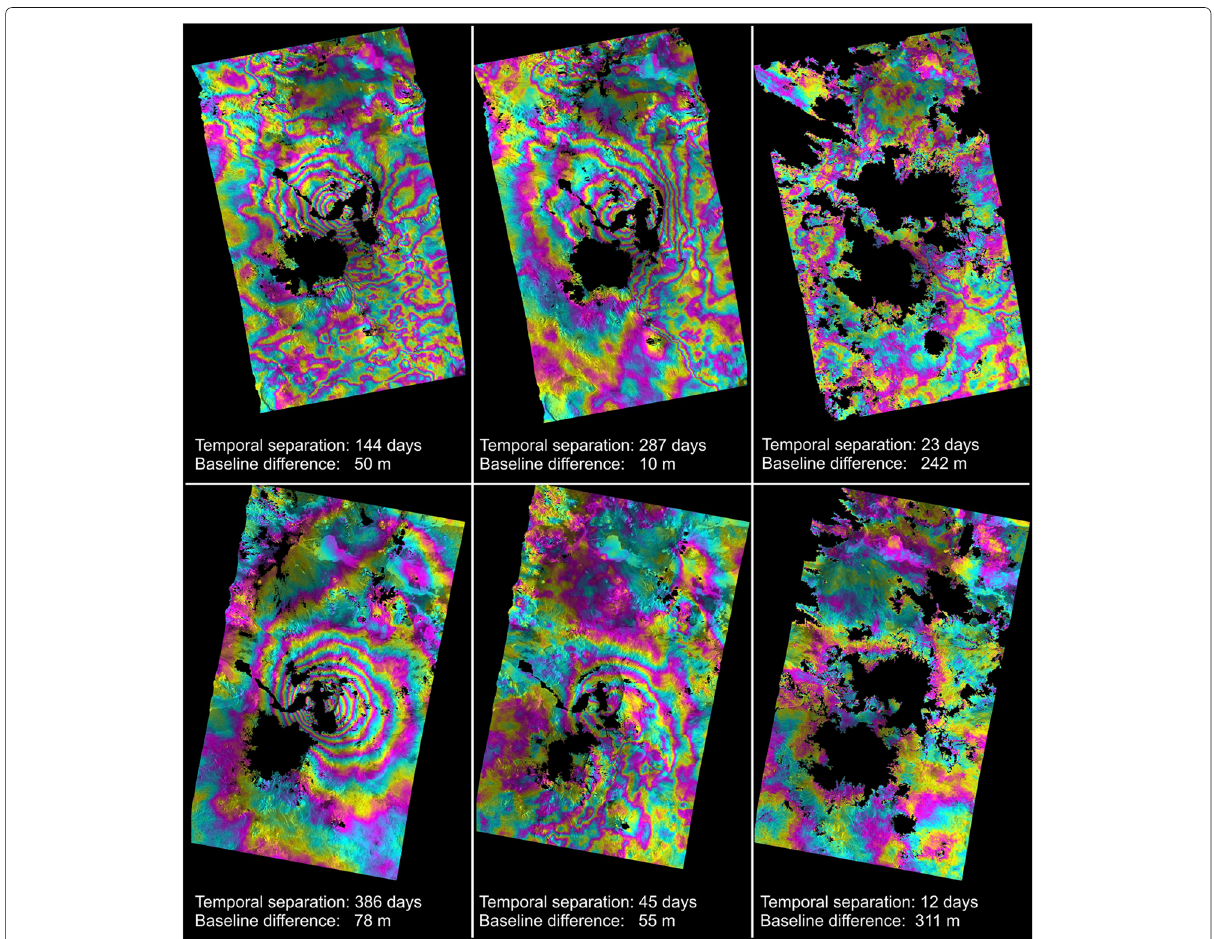
Fig. 2 Interferograms from the TSX satellite showing the coherence over different temporal separations and spatial baselines. The interferograms are wrapped at 2 π . Interferograms with baselines larger than 200 m with less than 90% unwrappable pixels were not used in this study